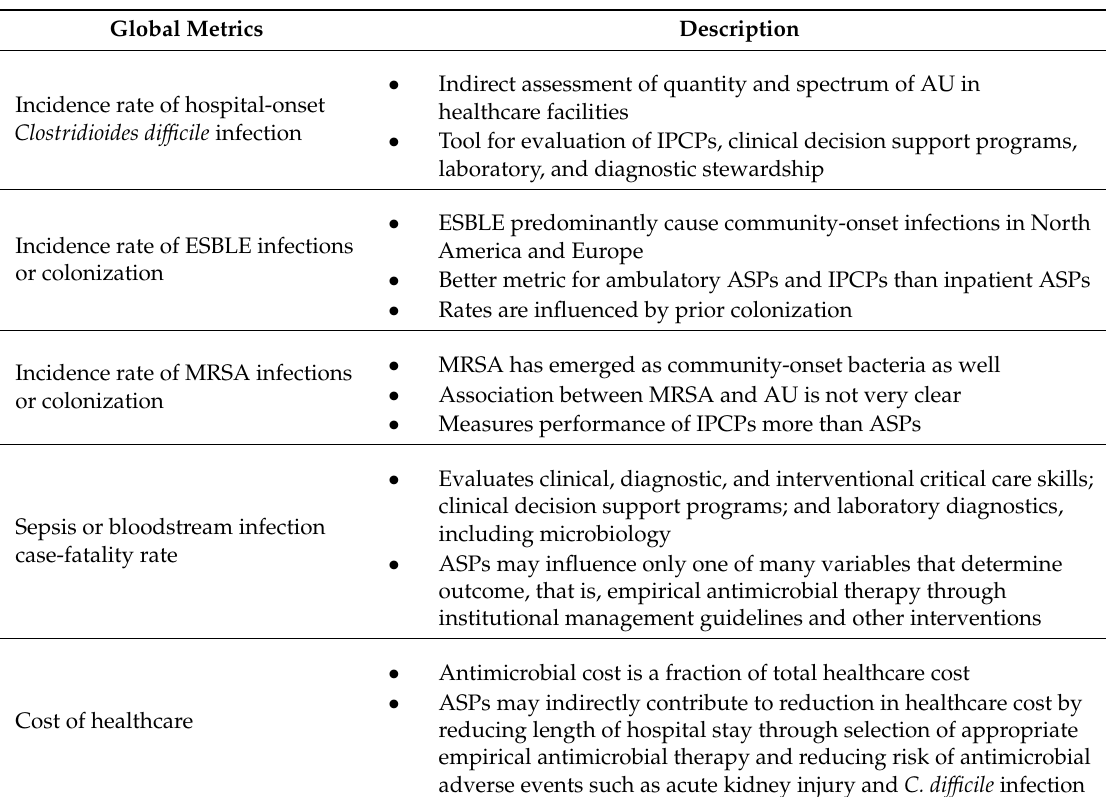
Table 5. Global metrics of overall healthcare system